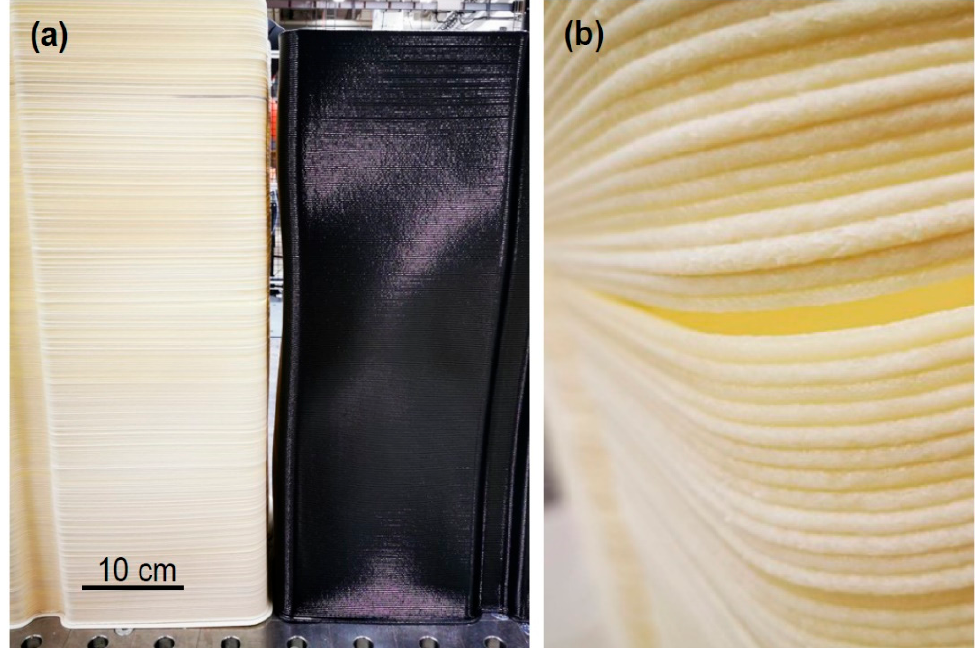
Figure 4. ( a ) Photograph of two straight boxes printed from ABS+15%GF ( left ) and pure ABS ( right ). ( b ) Enlarged view of delamination at the corner of the ABS+15%GF box.